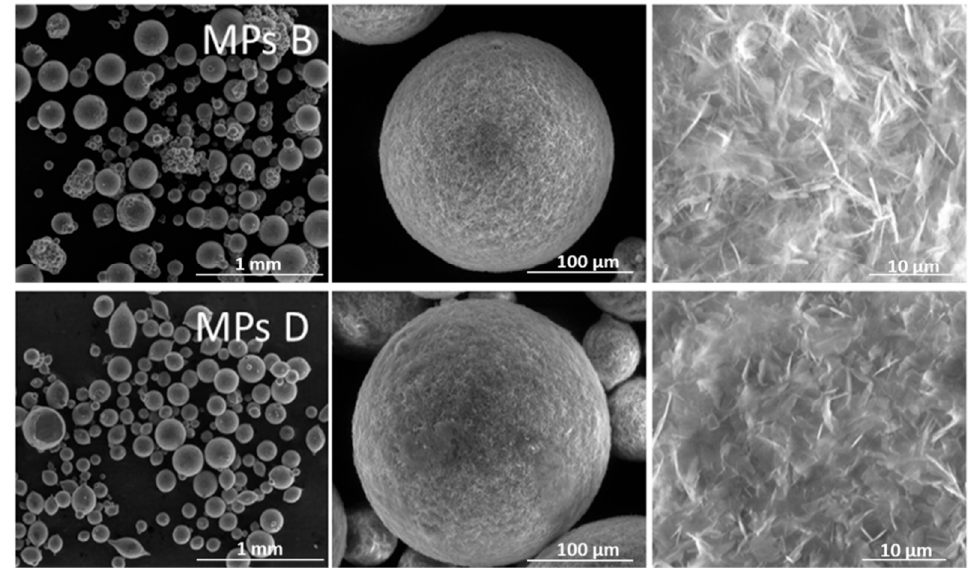
Figure 7. Environmental Scanning Electron Microscopy (ESEM) pictures of MPs B (containing Form B) and MPs D (containing PZQ) (magnification 60×, 500×, and 4.0 K×, in the order from left to right).